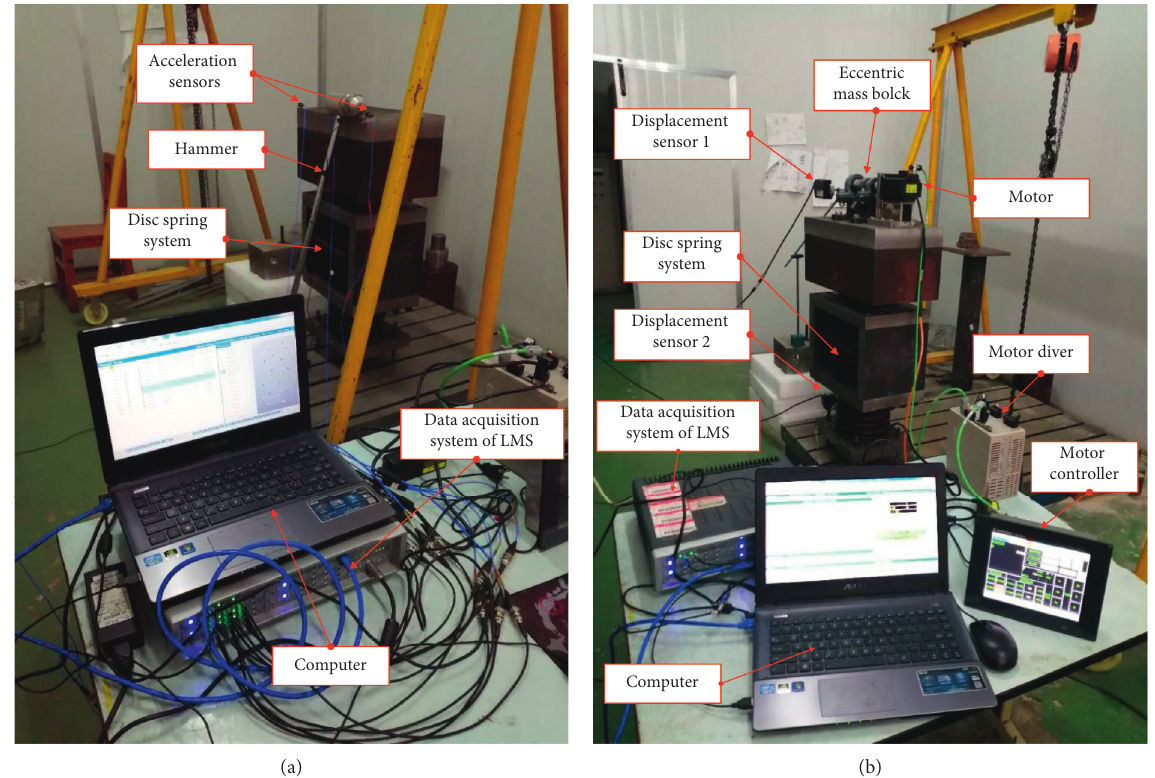
Figure 4: Specific experimental equipment and scenarios: (a) modal test and (b) amplitude